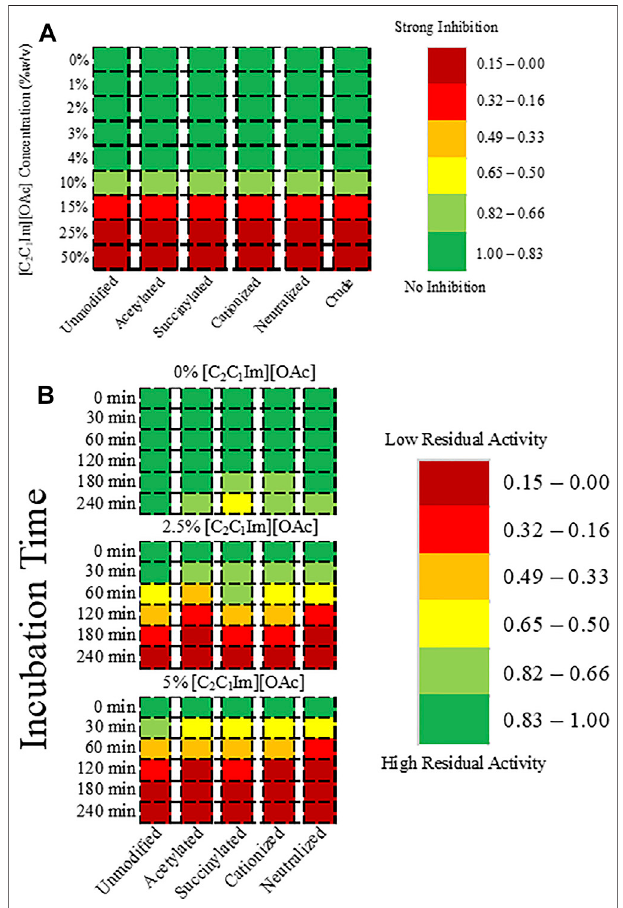
FIGURE 1 | Heatmap showing (A) the activity of MtL and the charge variants in [C 2 C 1 Im][OAc] relative to MtL activity in buffer, and (B) the residual activity of MtL charge variants after incubation in 50 mM citrate/100 mM phosphate buffer and 2.5 or 5% [C 2 C 1 Im][OAc] at pH 4.5 and 40 °